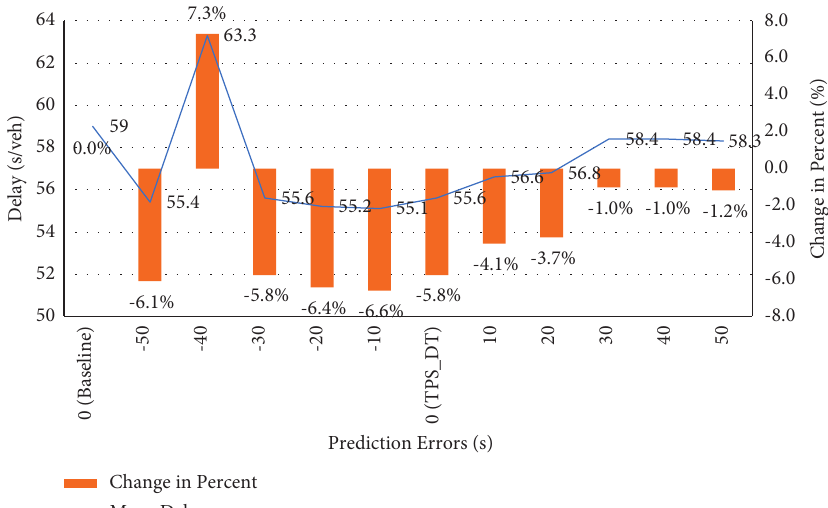
Figure 13: Average corridor delay versus prediction